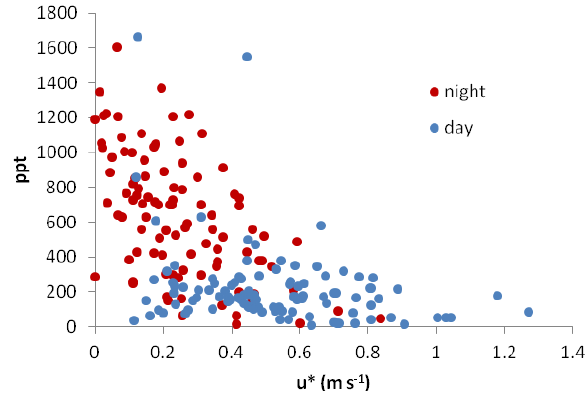
Fig. 9. The monoterpene mixing ratio dependence on friction veloc- ity in June, July and August.